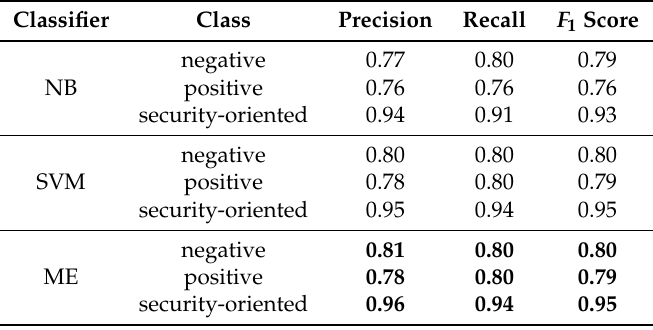
Table 4. Classification results of NB, SVM and